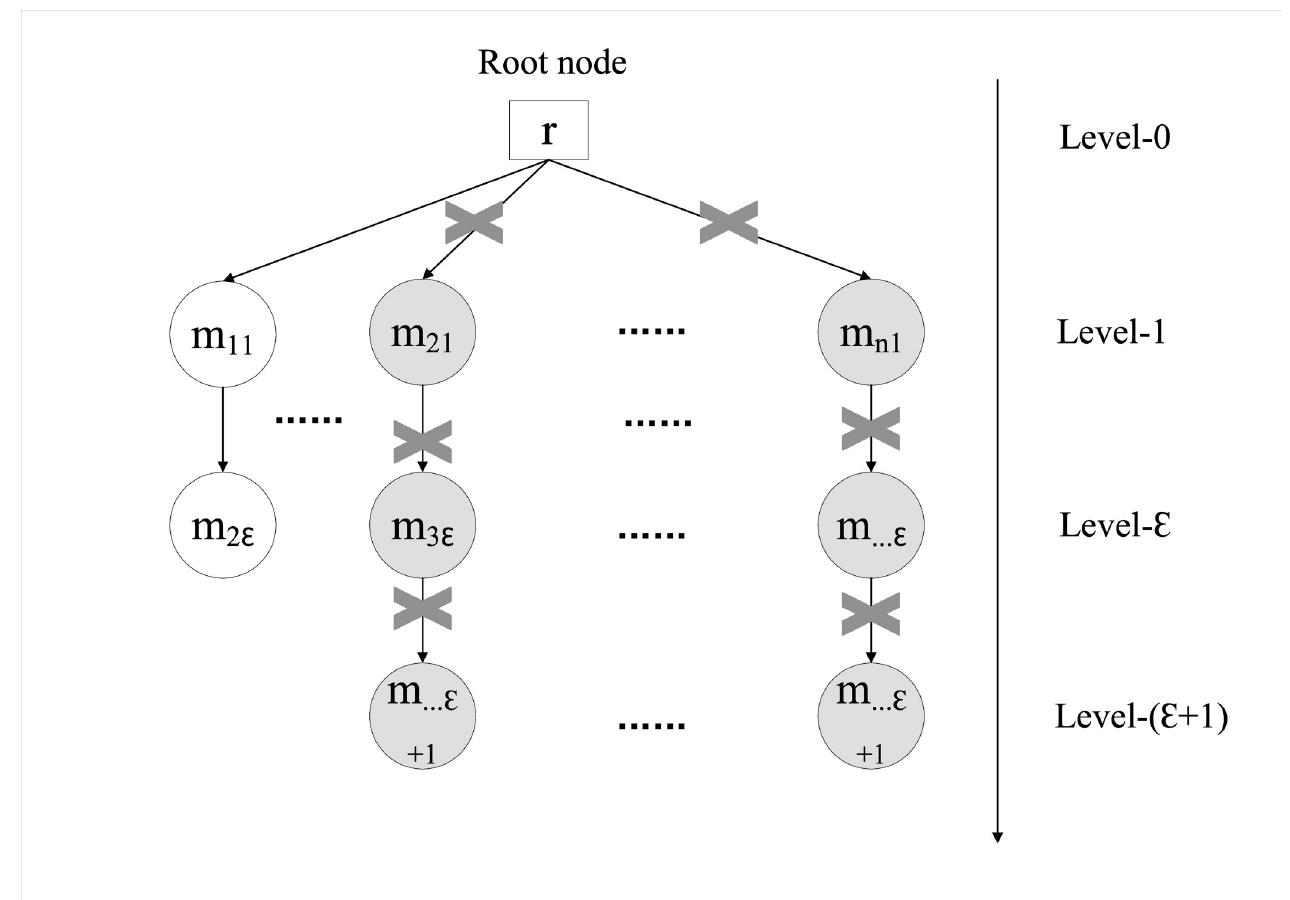
Fig 4. The breadth-first search tree. Note: search the node tree from node r of level-0, and when a branch tree does not meet the requirements, delete the branch and continue to search other branch trees.